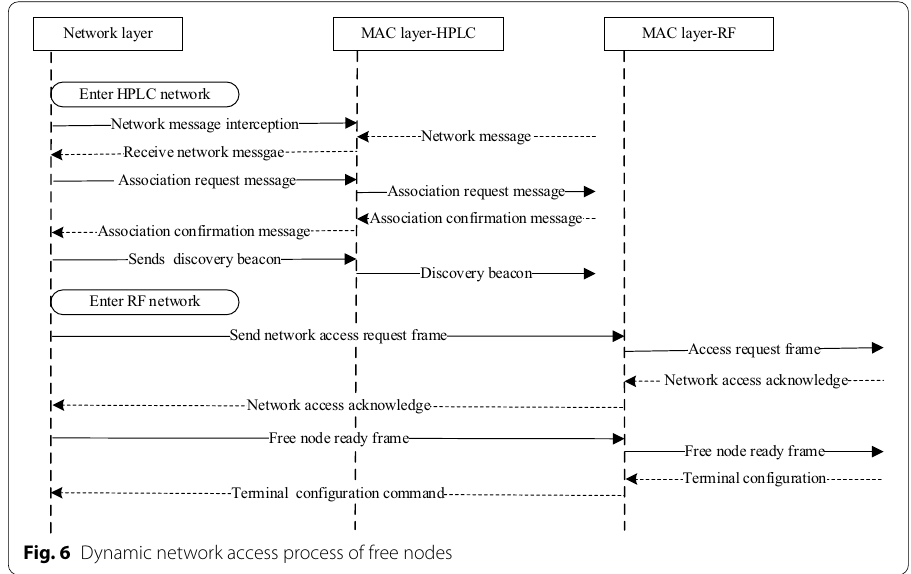
Fig. 6 Dynamic network access process of free